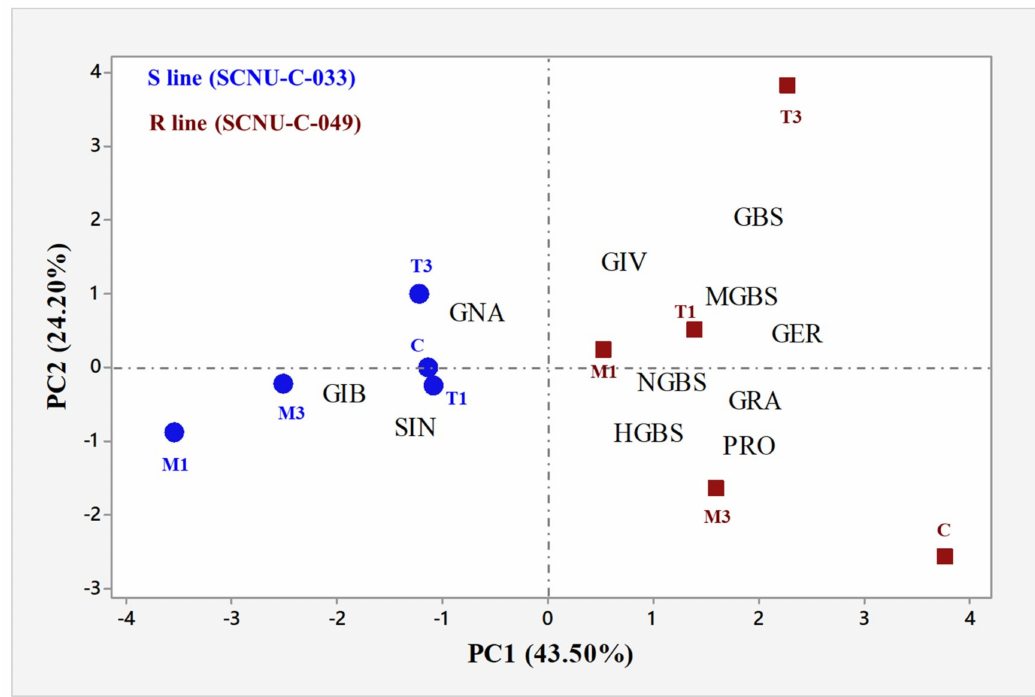
Figure 6. Biplot of white-mold-inoculated R (SCNU-C-049) and S (SCNU-C-033) cabbage lines and individual glucosinolate components, as determined by principal component analysis (PCA). Dark red squares denote mean PC scores of the R line, and blue circles those of the S line. Fungal treatments: C, control; M1, mock day 1; T1, treated day 1; M3, mock day 3; T3, treated day 3. Glucosinolate (GSL) components: GIB, glucoiberin; PRO, progoitrin; GRA, glucoraphanin; SIN, sinigrin; GNA, gluconapin, GIV, glucoiberverin; GER, glucoerucin; GBS, glucobrassicin; NGBS, neoglucobrassicin; MGBS, methoxyglucobrassicin; HGBS, hydroxyglucobrassicin. R, resistant; S,